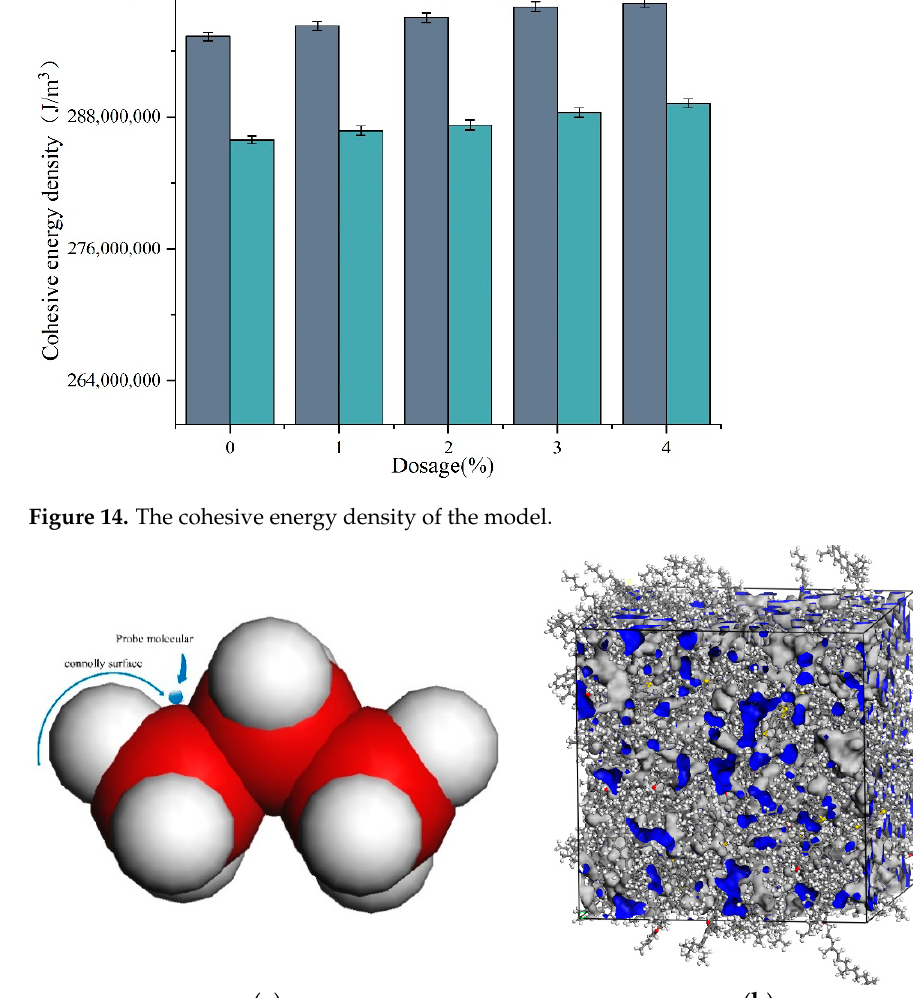
Table 4. The fractional free volume of asphalts (298 K).